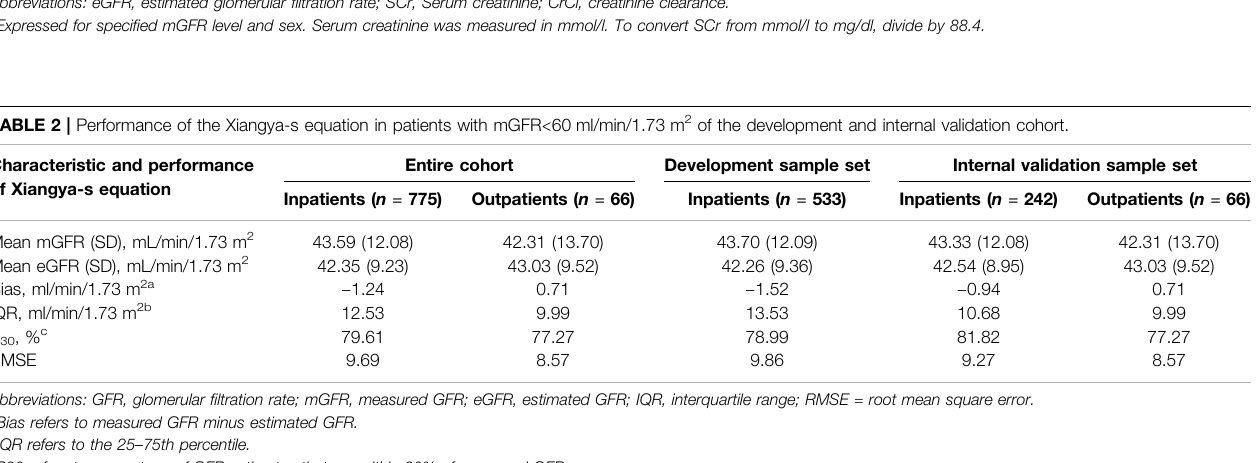
TABLE 1 | The novel equation for estimating GFR in Chinese population with CKD a . Name Applicable population Sex Equation Xiangya-s